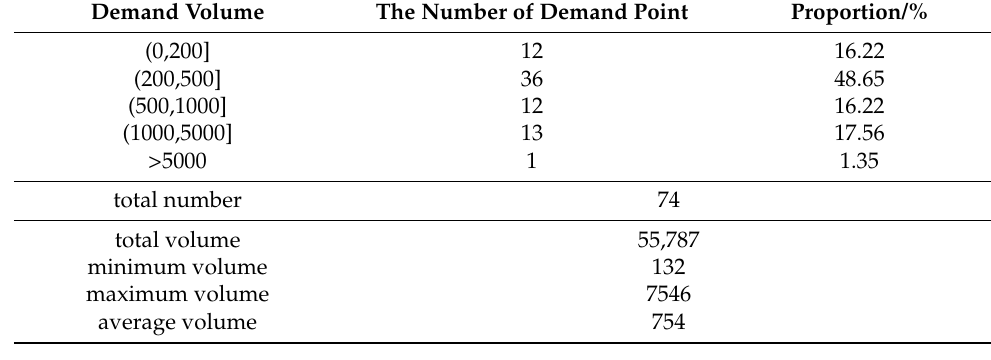
Figure 9. Distribution of logistics demand.